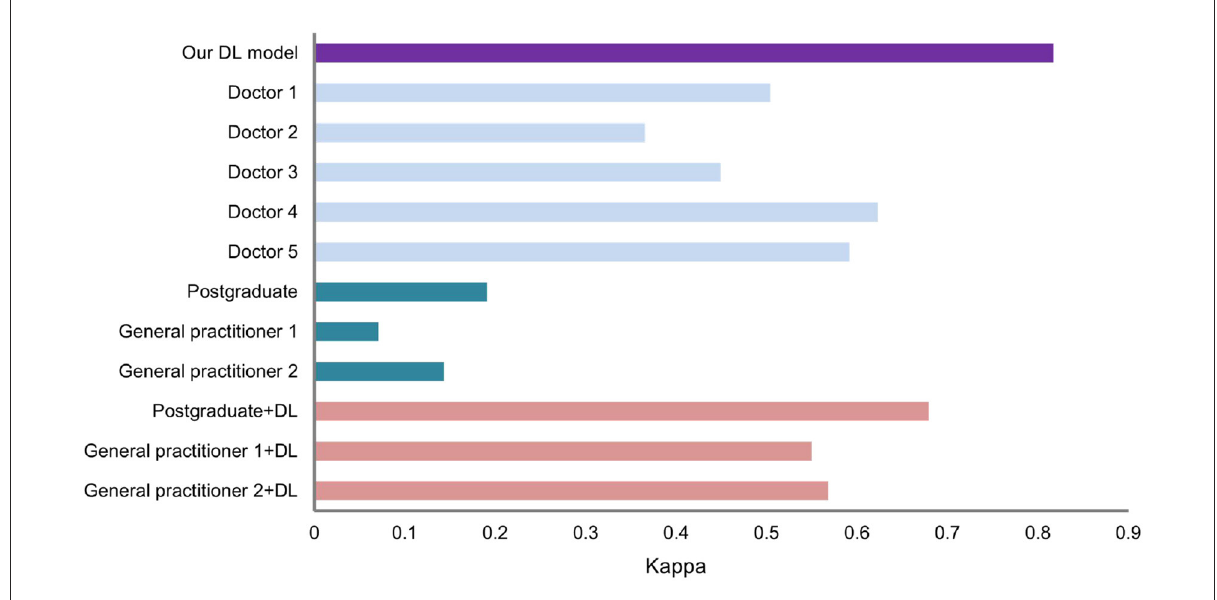
FIGURE7 Kappa value of the DL model and dermatologist.